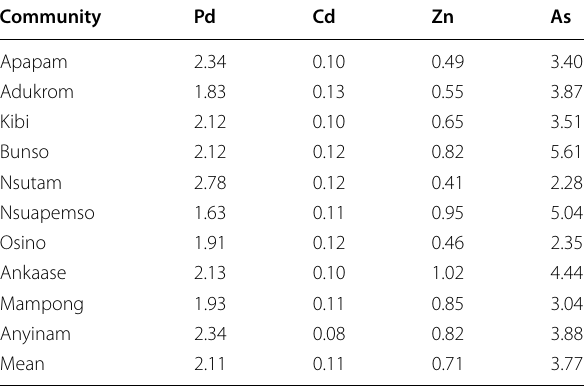
Table 6 The computed EF values for heavy metals in sedi- ments samples collected from the Birim